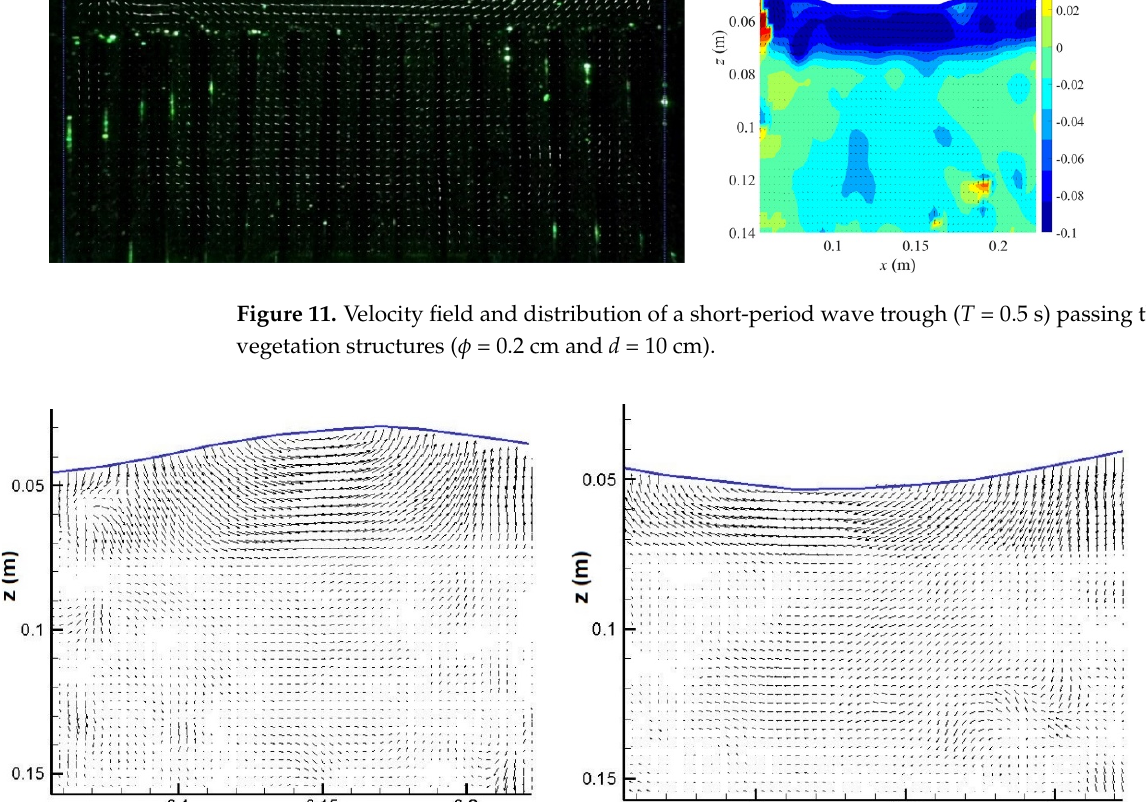
Figure 12. Velocity distribution of a short-period wave ( T = 0.5 s) around vegetation region ( ϕ = 0.2